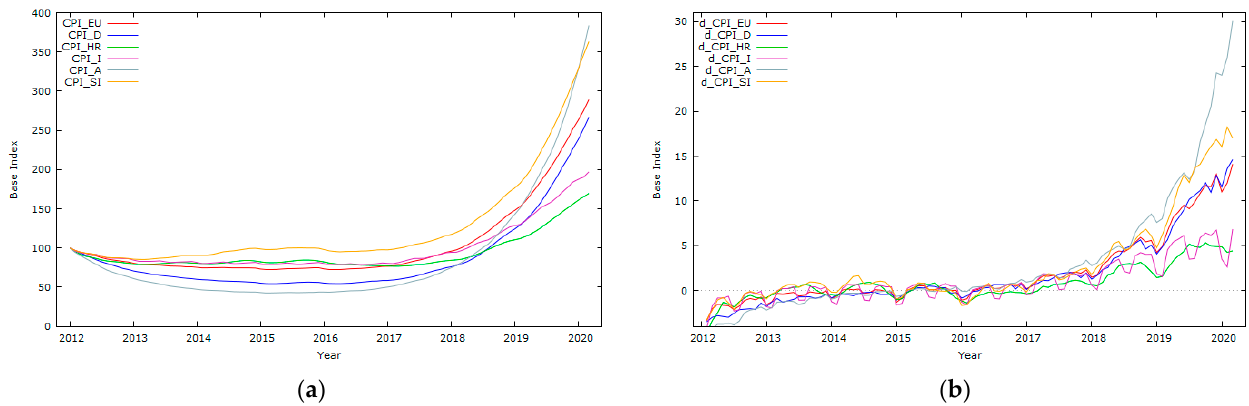
Figure A1. ( a ) Distribution of consumer price indices for Austria, Croatia, Germany, Italy, and Slovenia; ( b ) Distribution of 𝐼(1) Consumer price indices for Austria, Croatia, Germany, Italy, and Slovenia. Note. CPI—Consumer price index; EU—Eurozone; D—Germany, HR—Croatia, I—Italy, A—Austria, SI—Slovenia. Data vector January 2012 to March 2020 (expansion period); d— 𝐼(1) .